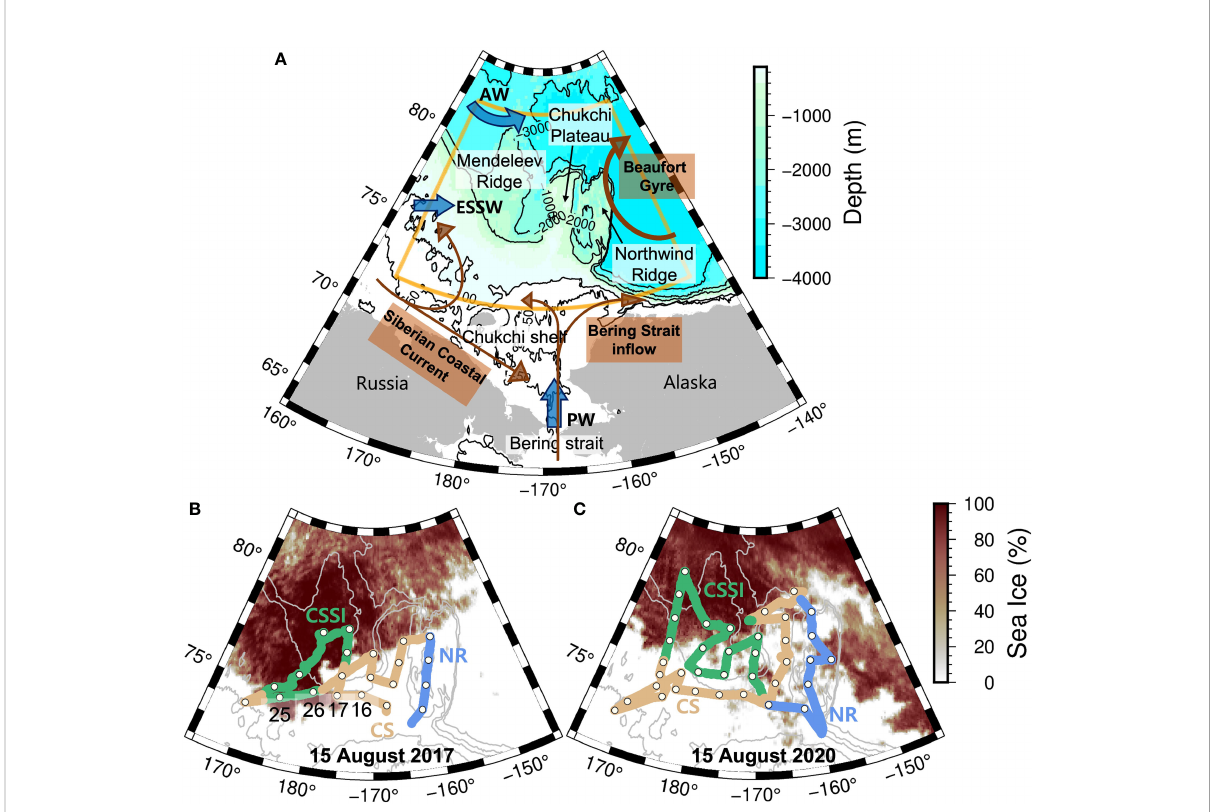
FIGURE 1 (A) Map of the Chukchi Sea. The surface circulation components are shown in brown arrows. The blue arrows denote water fl ows in the halocline layer: Atlantic Water (AW), Paci fi c Water (PW), East Siberian Shelf Water (ESSW). Orange sector shows the boundary of the map right below, which is the main study area. CTD stations (white circles with black edge) and cruise track in (B) 2017 and (C) 2020. Chukchi Sea sea ice (CSSI), Chukchi Sea (CS), and Northwind Ridge (NR) are marked in green, yellow, and blue, respectively. In both years, we depict sea ice concentration on August